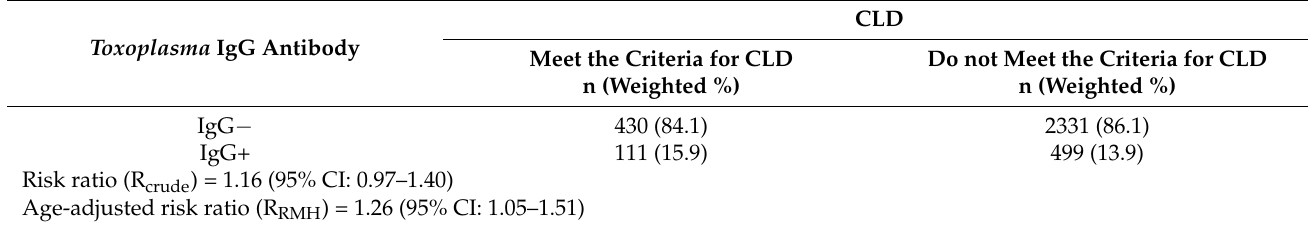
Table 4. Relative risk of CLD by T. gondii exposure status (IgG+/IgG − ).